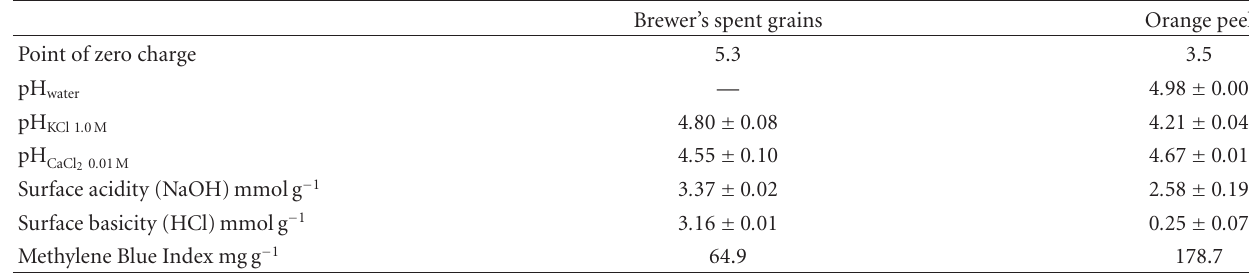
Table 2: Chemical and physical characterization of